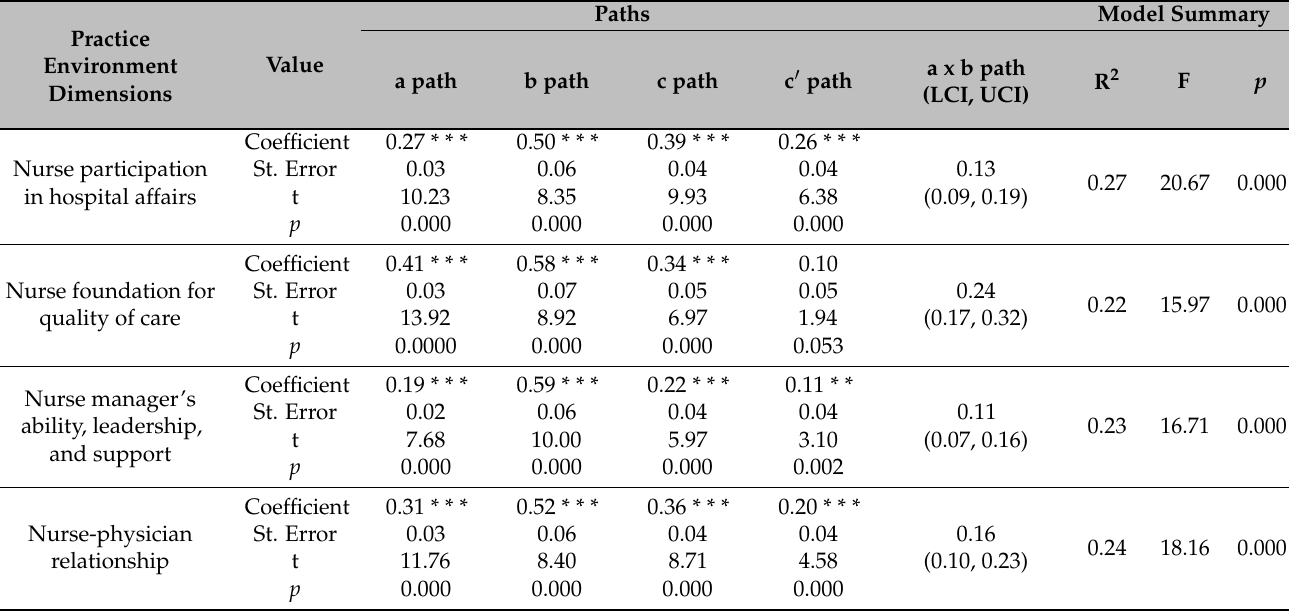
Table 4. The Mediation Effect of Person-centeredness on Patient Safety.